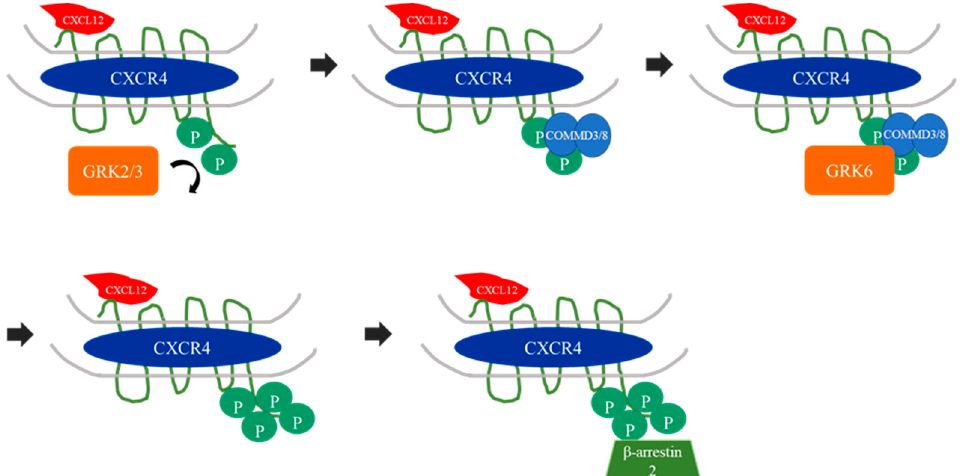
Figure 2. Possible mechanisms of COMMD3/8-mediated targeting of GRK6 to CXCR4 (simplified chart). Phosphorylation of the carboxy-terminal serine-353 and -354 by GRK2 or GRK3 seems to be